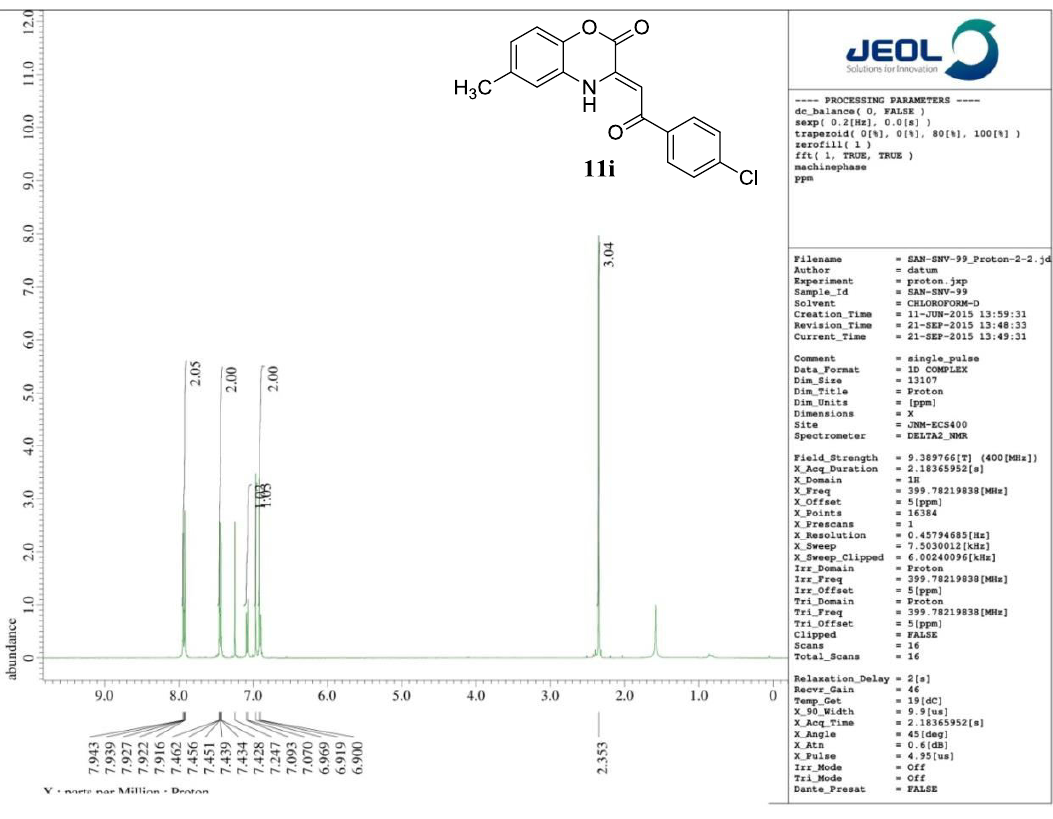
Figure 17. 1 H NMR Spectra of Compound 11i.